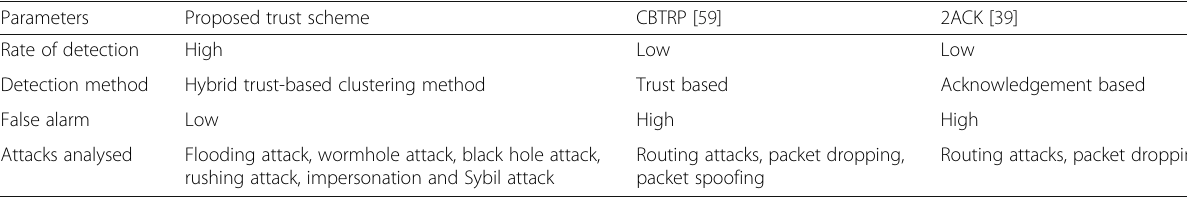
Table 2 Comparison of various MANET models